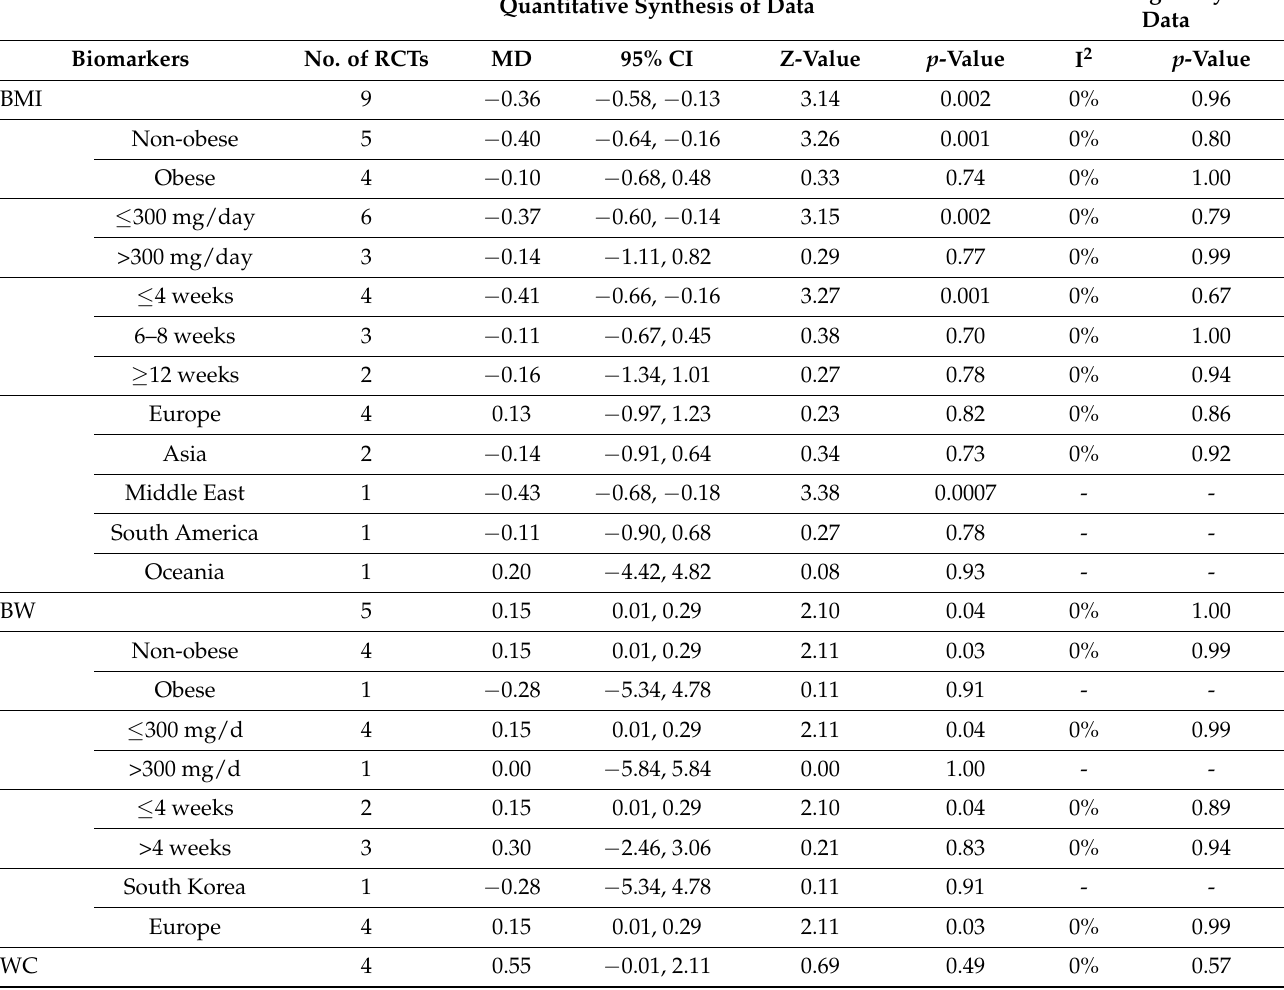
Table 2. Subgroup analysis by biomarker condition. Quantitative Synthesis of Data